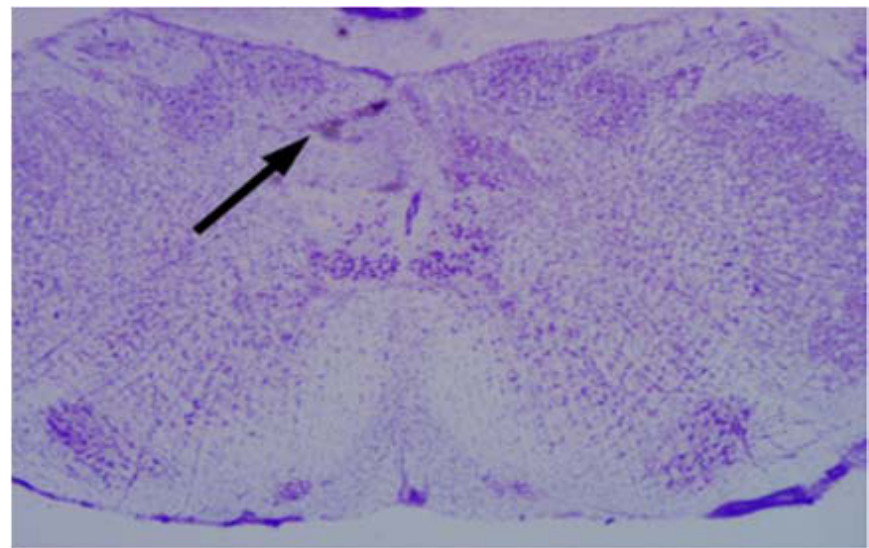
Figure 1. Brain stem showing the injection site in the commissural nucleus tractus solitarius.